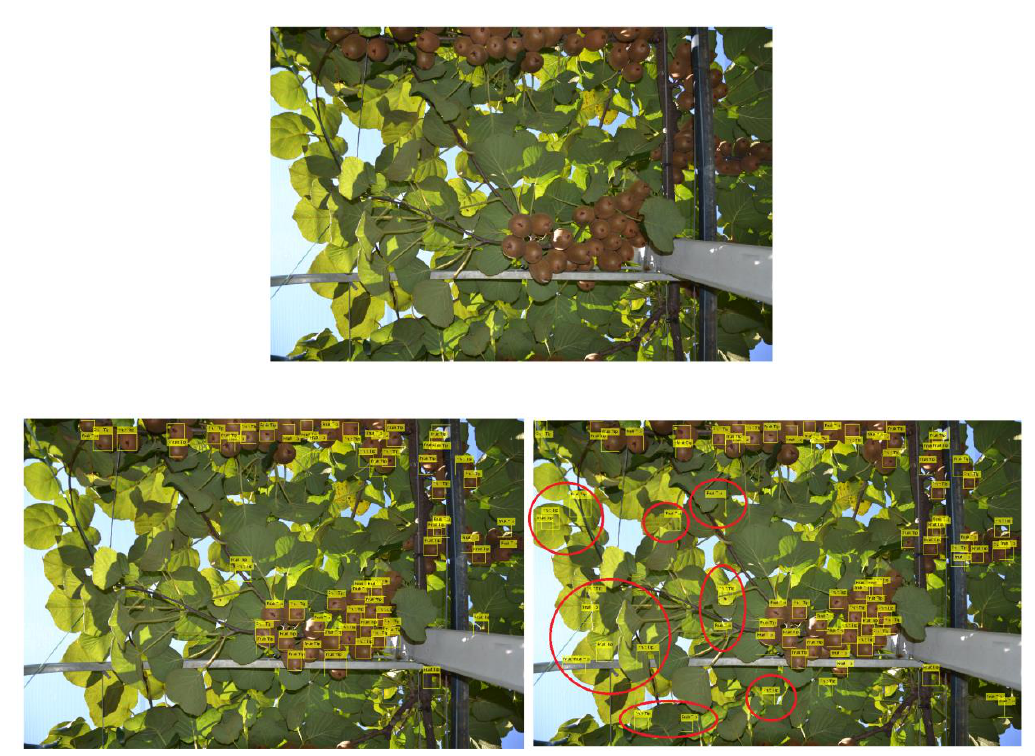
Figure 16. Example of kiwifruit detection with and without preprocessing using 6 cascades. ( Top ): original image. ( Bottom left ): detection with preprocessing. ( Bottom right ): without preprocessing where red circles indicate false alarms.